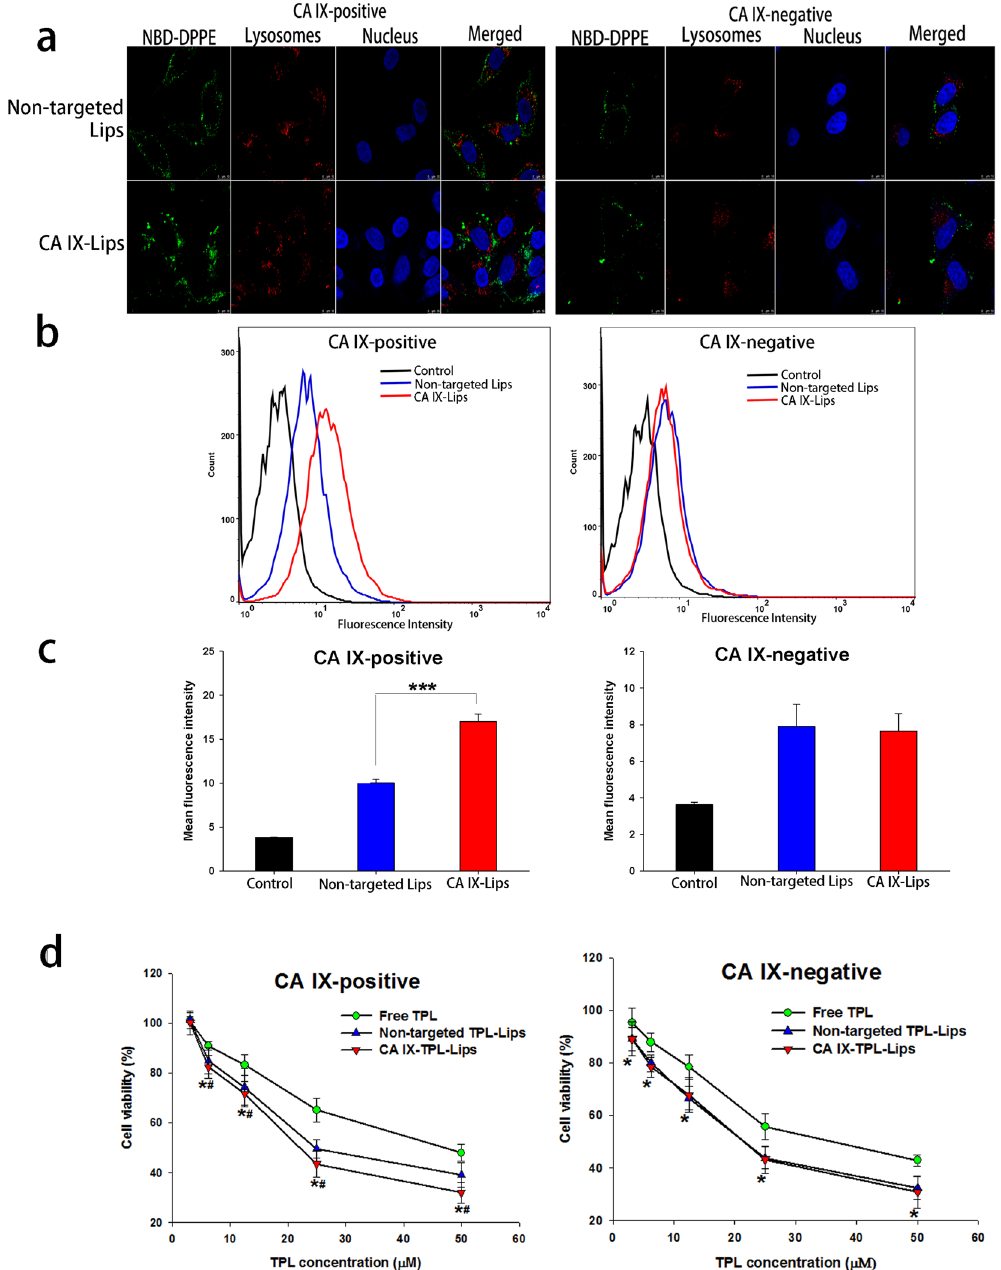
Figure 3. Cellular uptake and cytotoxicity of CA IX-TPL-Lips in NSCLC A549 cells. ( a ) Confocal laser scanning microscopy image of CA IX-negative and CA IX-positive A549 cells after treatment with NBD- DPPE labeled CA IX-Lips and non-targeted liposomes for 4 h; Scale bars, 10 μ m. ( b ) Quantitative analysis of NBD-DPPE-labeled liposomes uptake by flow cytometry. ( c ) Mean fluorescence intensity of NBD-DPPE- labeled liposomes after 4 h treatment; control cells were untreated. Data are presented as mean ± SD (n = 3), *** Indicates p < 0.001. ( d ) In vitro cytotoxicity of free TPL, non-targeted TPL-Lips and CA IX-TPL-Lips against CA IX-positive and CA IX-negative A549 cells assessed by MTT assay. Data are presented as mean ± SD (n = 3). * p < 0.05 compared with free TPL group; # p < 0.05 compared with non-targeted TPL-Lips